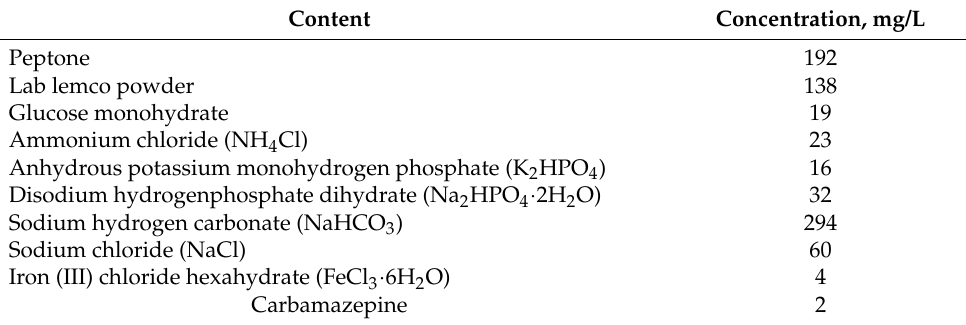
Table 4. Synthetic wastewater composition adapted from ISO11733 Standard.